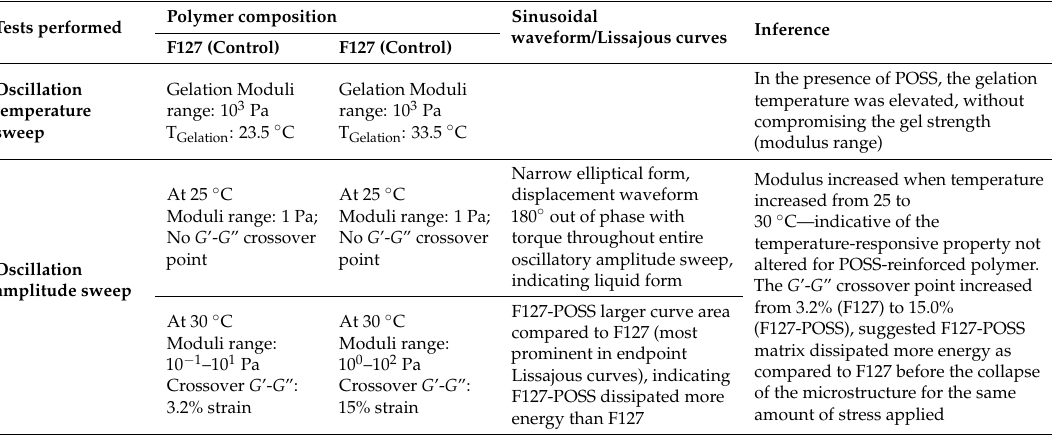
Figure 6. Oscillatory amplitude sweep of 15 wt % polymers at 30 °C; ( a ) F127, and ( b ) F127-POSS, and corresponding sinusoidal waveforms. The tests were performed at a strain prcent range of 0.5%–150%, with a fixed frequency at 1 Hz. Table 3. The summary of rheological analysis.